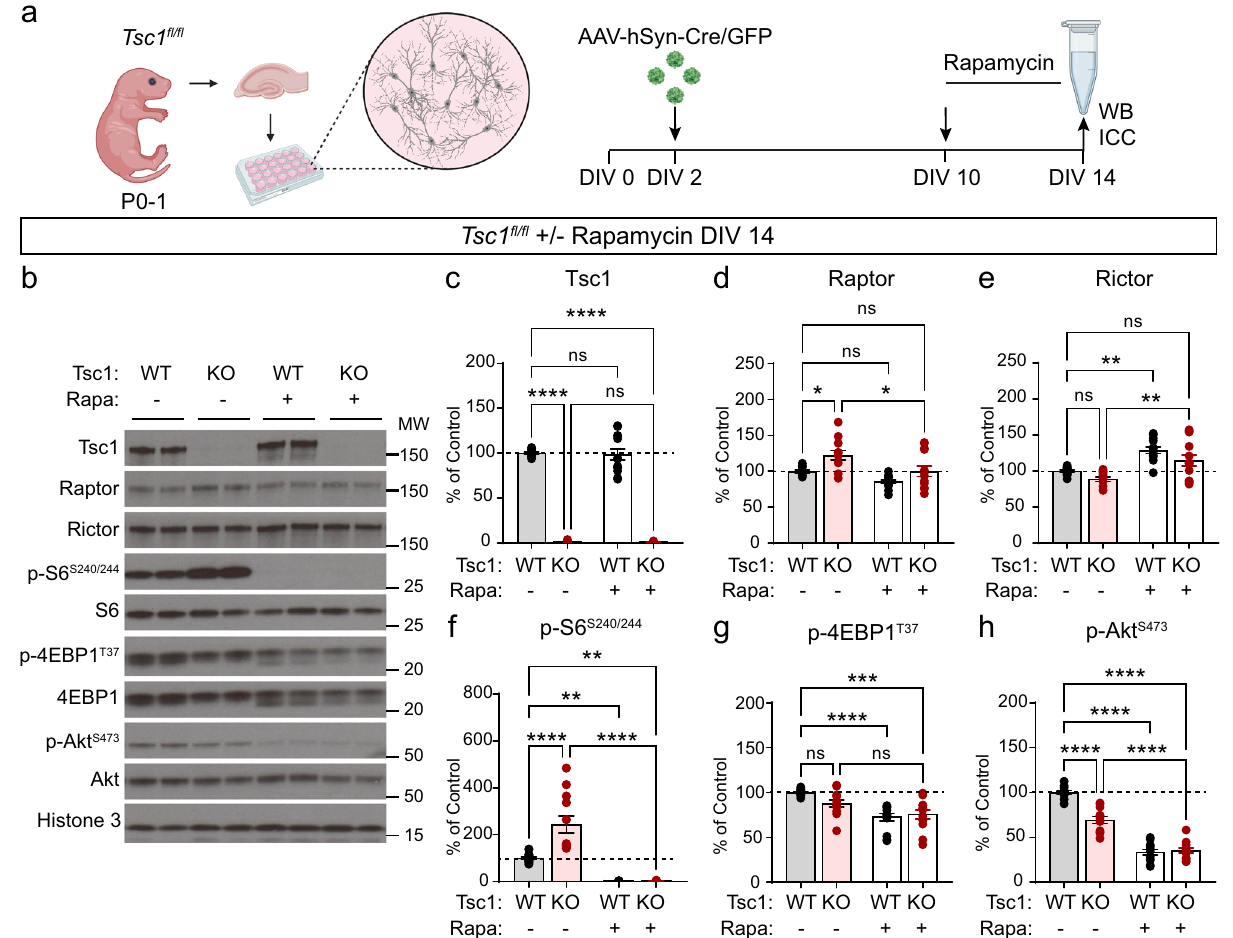
Fig. 1 | Chronic rapamycin suppresses mTORC1 and mTORC2 signaling in cul- tured Tsc1-cKO neurons. a Schematic of the experiment, created with BioR- ender.com. b Representative western blots (WB) from Tsc1 fl / fl cultures with (+) or without ( − ) four-day rapamycin (Rapa) treatment. MW indicates molecular weight. WT= Tsc1 fl / fl + AAV-GFP; KO= Tsc1 fl / fl + AAV-Cre-GFP. Two independent samples per genotype are shown. This experiment was replicated 5 times. c – h Bar graphs dis- play WB quanti fi cation (mean ± SEM) for the indicated proteins, expressed as a percentage of Control (WT) levels. Phospho-proteins were normalized to their respectivetotalproteins.Dotsrepresentdatafromindividualculturewells.WT n = 11,KO n =12,WT+Rapa n =13andKO+Rapa n